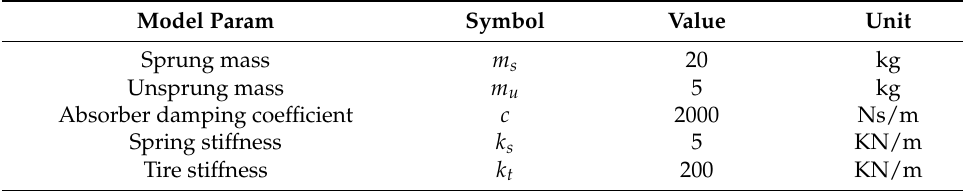
Table 1. Parameter Table of the Suspension Model.